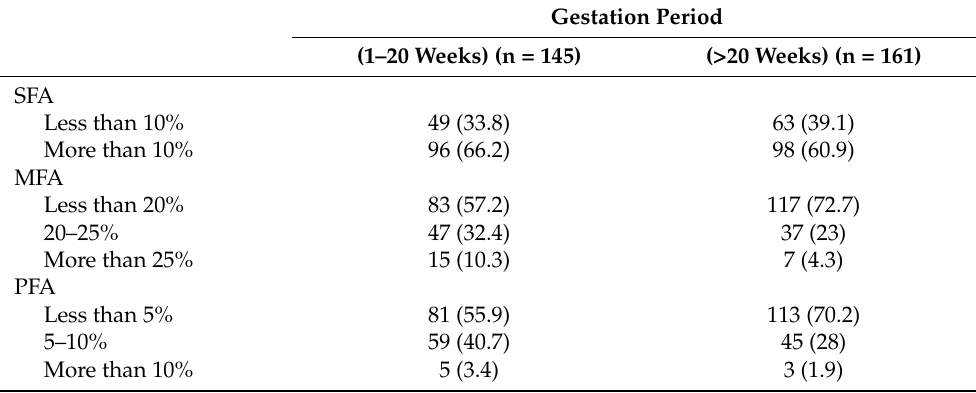
Table 5. Contribution of the different fatty acids (MFA, PFA, and SFA) to the TCV (Lipid profile) (frequencies and